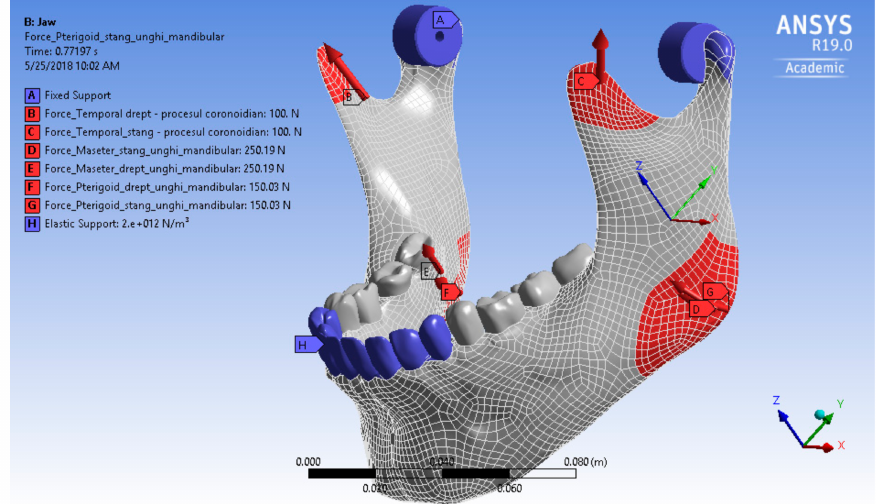
Figure 3. The boundary conditions for the frontal bite model. A: fixed support; B–G: forces from the masticatory muscles; H: elastic